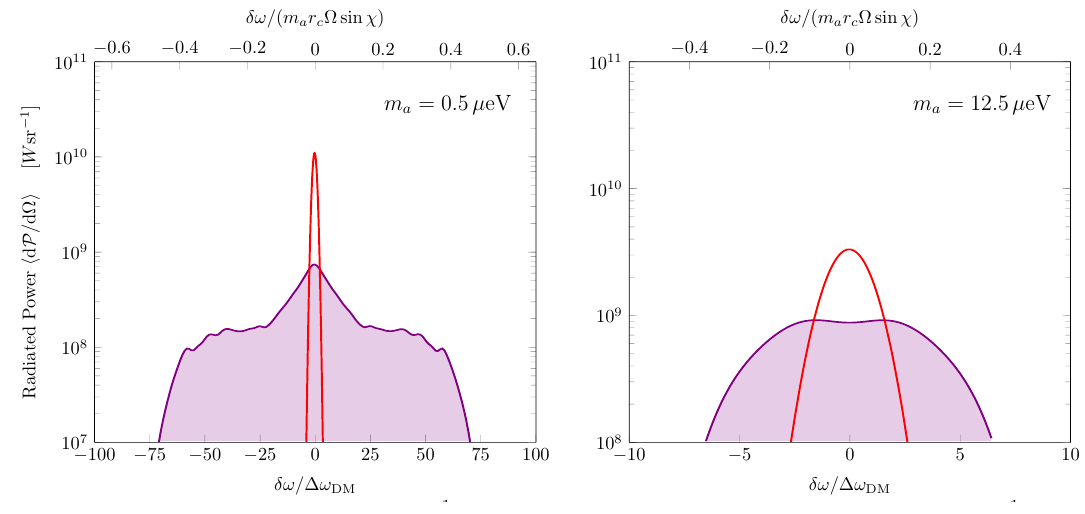
Figure 5 . Pulse-averaged line shapes. Line profile (purple) of the Doppler broadened radio line computed via evolving eq. (3.8) along rays. We took an observing angle θ = 36 ◦ . Other model parameters are as for figure 3. The bottom axis shows the width relative to that set by velocity v 2 m a with v 0 = 6 × 10 − 4 corresponding to a dark matter dispersion of dark matter ∆ ω DM = 1 0 2 velocity v 0 = 200 km sec − 1 . The top axis compares the width to the analytic estimate (4.11). We display the original un-broadened Gaussian line signal in red.